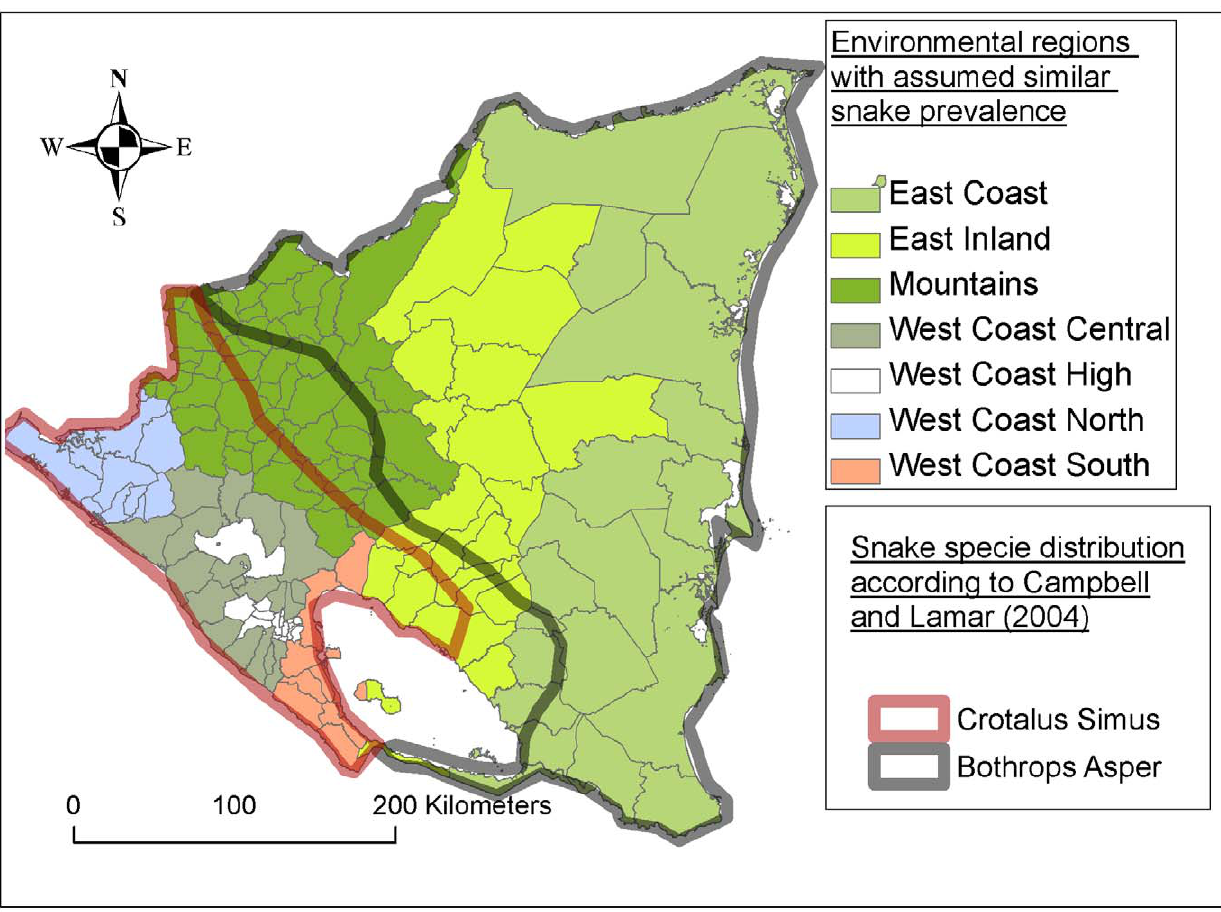
Figure 2. Environmental regions and snake distribution. Within the environmental regions, homogenous snake prevalence is assumed based on similarities in altitude, precipitation and geographical location (see Methods section).